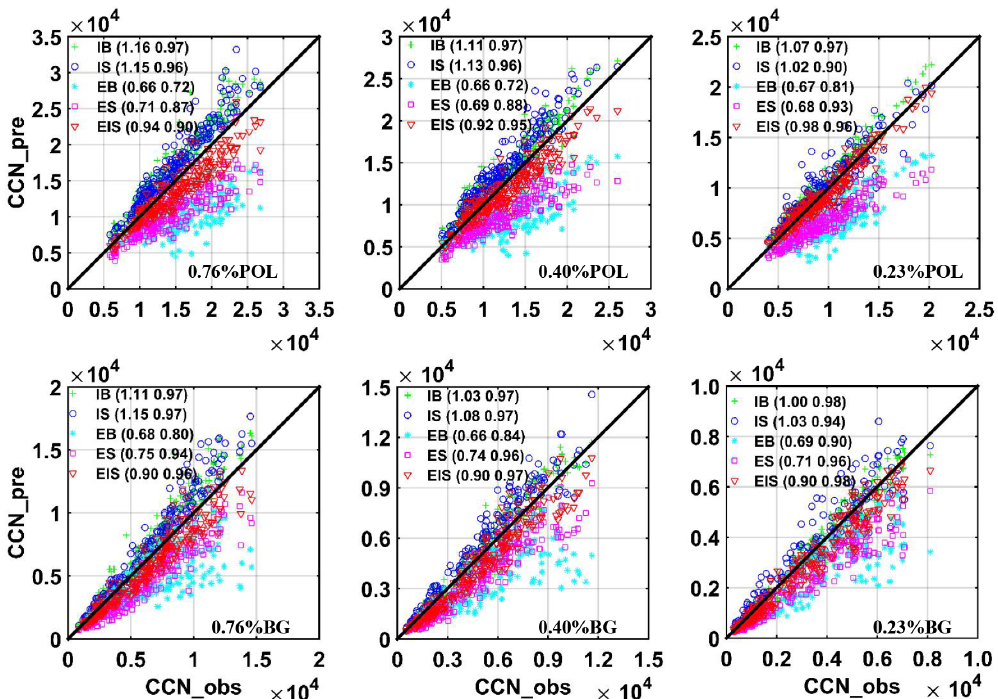
Figure 6. Predicted N CCN as a function of measured N CCN using the five assumptions (colored symbols – scheme associated with each symbol listed in detail at the end of this caption) at three supersaturation levels (0.23, 0.40, and 0.76%) under polluted (POL) and back- ground (BG) conditions. The numbers in parentheses are the slope (first number) and the correlation coefficient (second number). + INT–BK (IB) internal mixture, bulk composition; ◦ INT–SR (IS) internal mixture, size-resolved composition; ∗ EXT–BK (EB) external mixture, bulk composition; (cid:3) EXT–SR (ES) external mixture, size-resolved composition; (cid:79) EI–SR (EIS) external mixture, sulfate, nitrate, SOA, and aged BC internally mixed, and POA and fresh BC externally mixed, size-resolved composition.